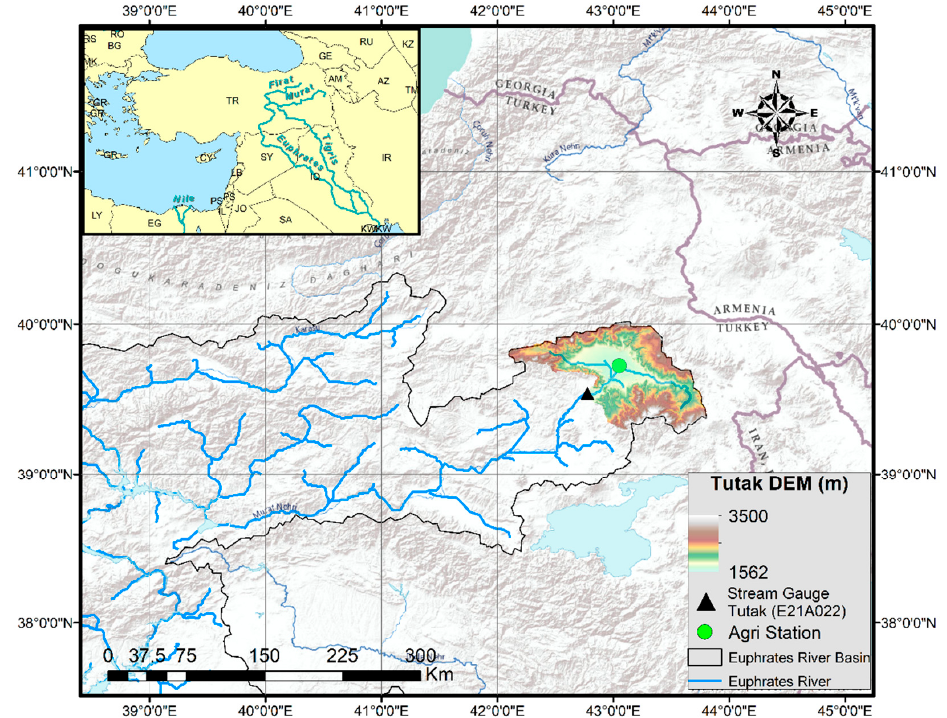
Figure 2. Location, digital elevation model, and the observation network of the Upper Murat (Tutak) Basin.